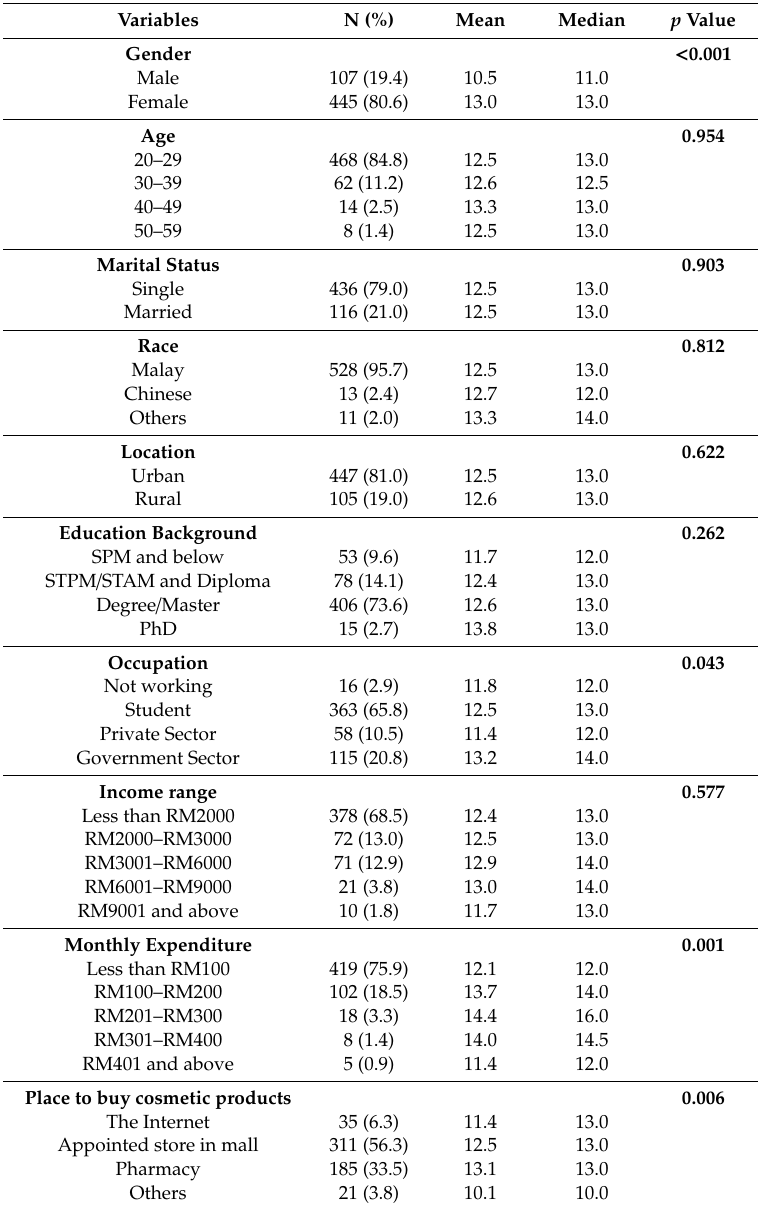
Table 4. Total knowledge score di ff